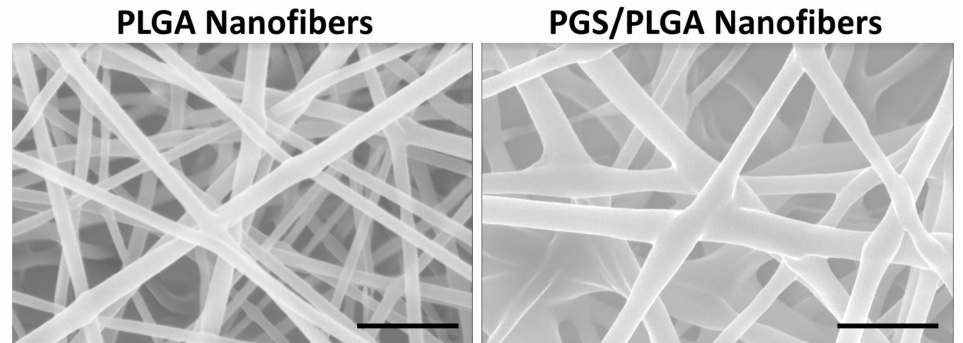
Figure 3. Comparison of fiber diameters for poly (lactic co glycolic acid) PLGA and poly (glycerol sebacate) (PGS)/PLGA core-shell nanofibers. SEM images. PLGA and PGS/PLGA fibers mats have average diameters of 190 ± 33 nm and 245 ± 61 nm, respectively, which was measured from SEM images. Scale, 1000